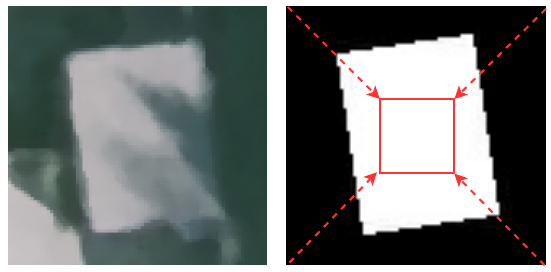
Figure 2. RGB patch of an aerial image of size 80 × 80 pixels and its corresponding ground truth. The area of 24 × 24 pixels inside the ground truth is the target of the